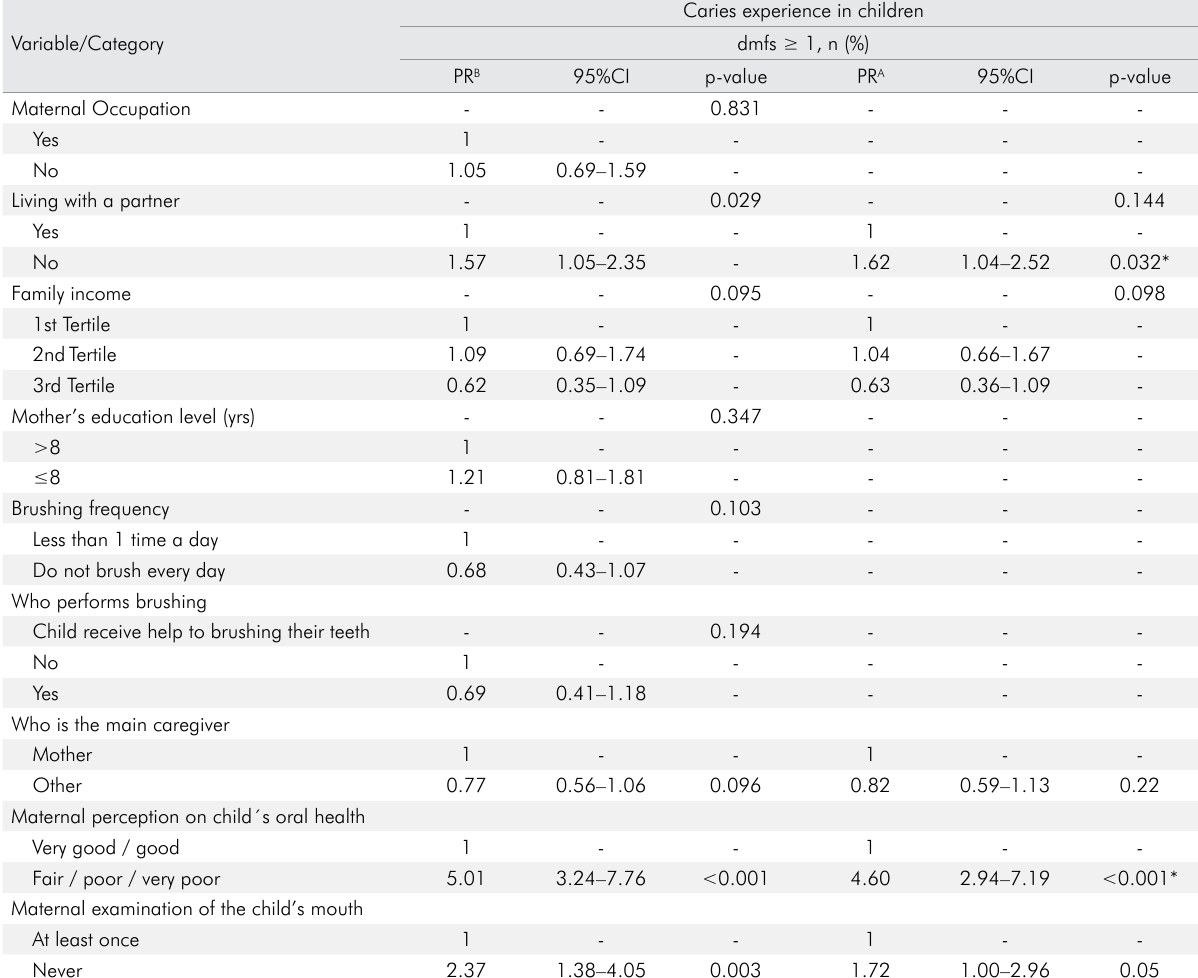
Table 2. Crude and adjusted analyzes for variables socioeconomic characteristics and maternal demographic, hygiene, care and caries experience in children in a mother sample adolescents in the city of Pelotas, RS, Brazil, 2015.